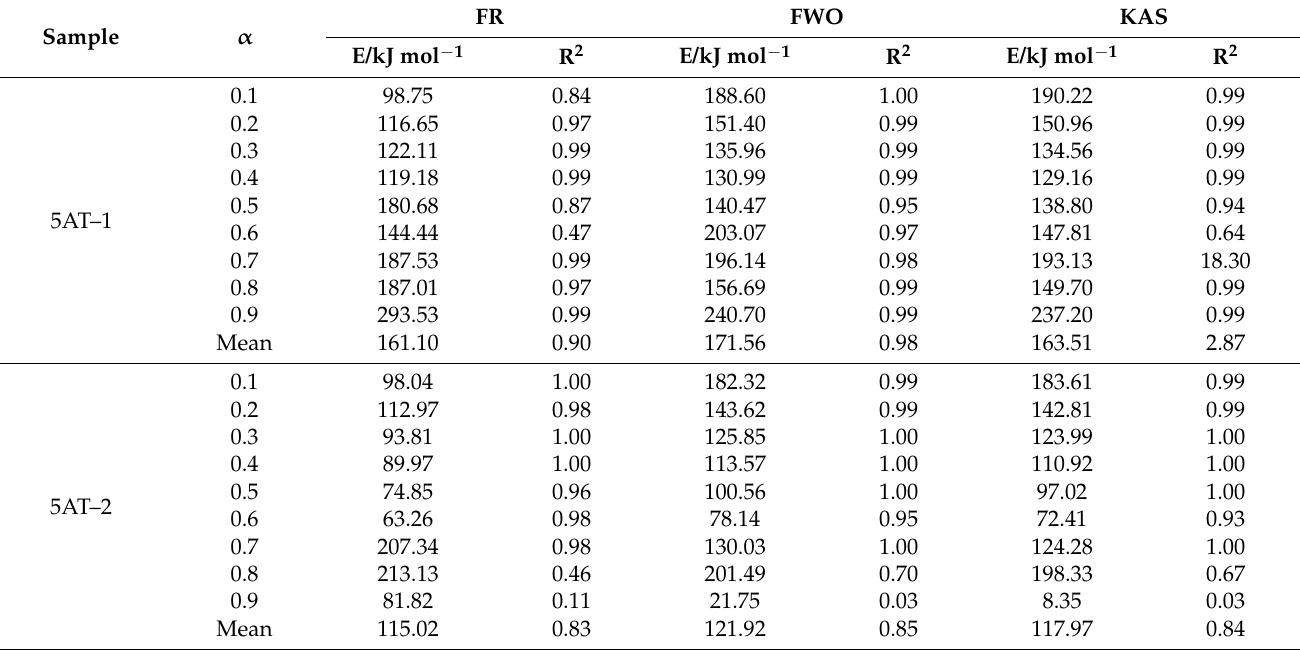
Table 3. Characteristic kinetic parameters for 5AT–1 and 5-AT-2, varying with conversion